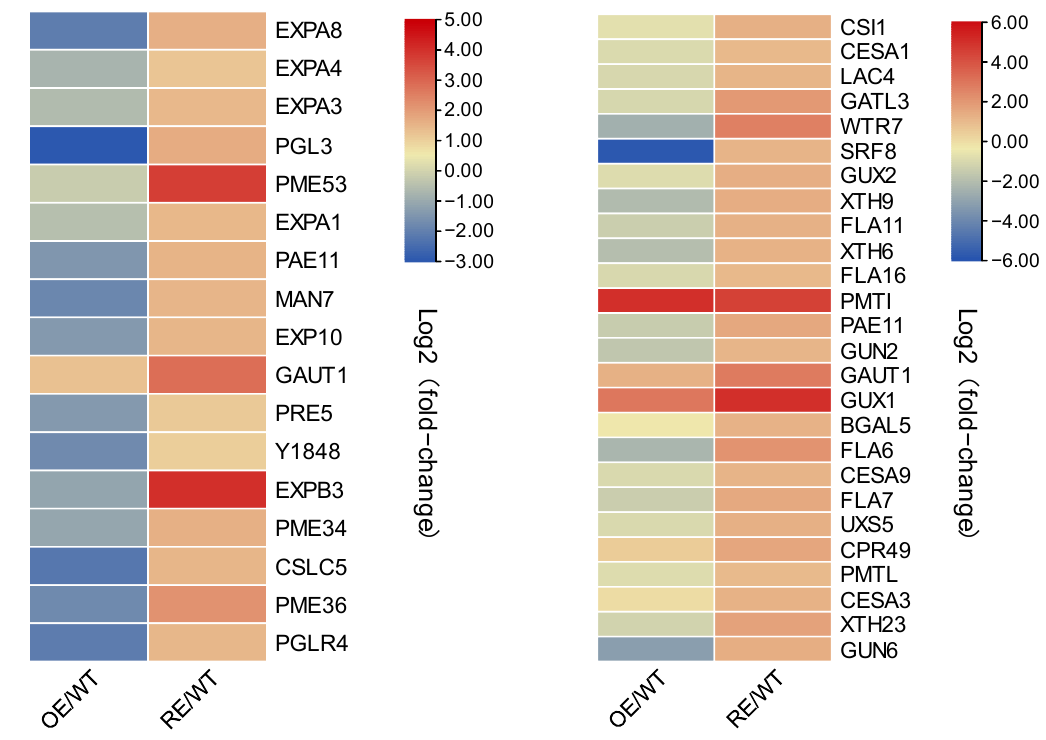
Figure 9. The expression of genes related to cell wall tissue biogenesis and polysaccharide metabolism in poplar.